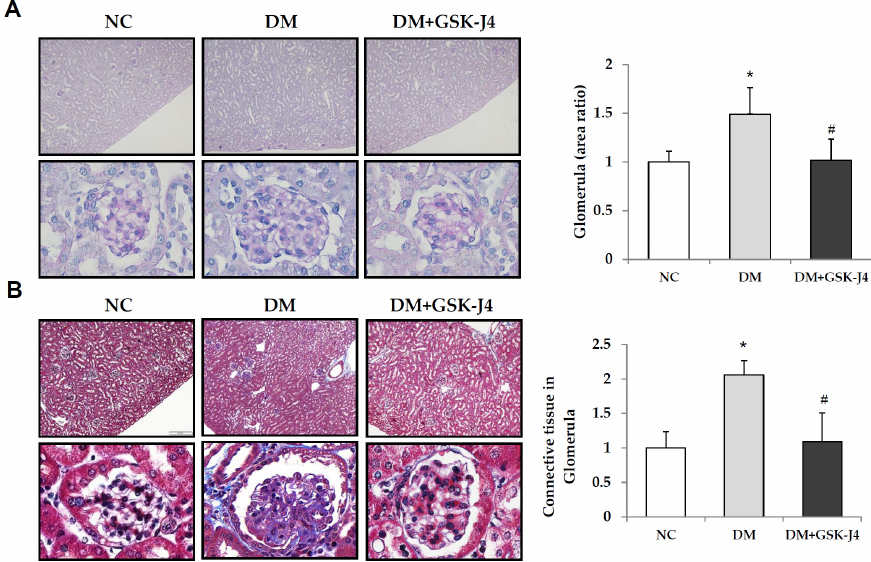
Figure 1. Periodic acid–Schiff (PAS) staining and Masson trichrome staining of kidneys from the mice. The mice were divided into three groups: normal mice (NC), STZ-induced diabetic mice (DM), and STZ-induced diabetic mice with GSK-J4 treatment (DM + GSK-J4). ( A ) Kidneys were stained with a PAS stain to detect glomerular damage. Glycogen, acid, and neutral epithelial mucin are stained magenta; nuclei are stained blue. ( B ) Masson trichrome staining of fibrosis in kidneys. The connective tissue is stained blue, nuclei are stained dark red/purple, and the cytoplasm is stained red/pink. (Enlargement factor: upper, 100 × ; lower, 1000 × .) The right panel shows relative quantification of the glomerular area and connective tissue in the glomerular. * p < 0.05 versus the control group; # p < 0.05 DM versus DM + GSK-J4. Abbreviations: DM, STZ-induced diabetic mice; NC, normal